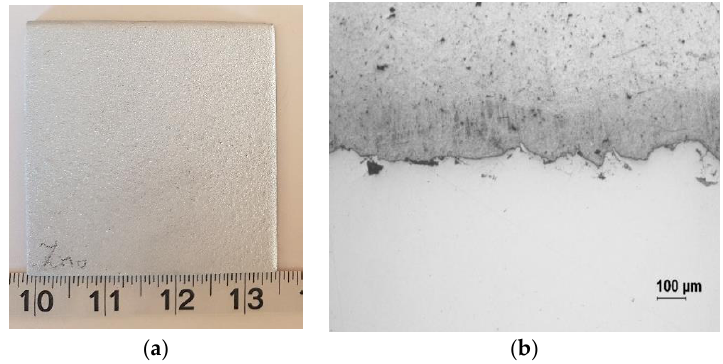
Figure 3. Cross-section of the wire-arc Al-Zn coating ( a ) and microscope image of wire-arc Al-Zn coating interface ( b ).